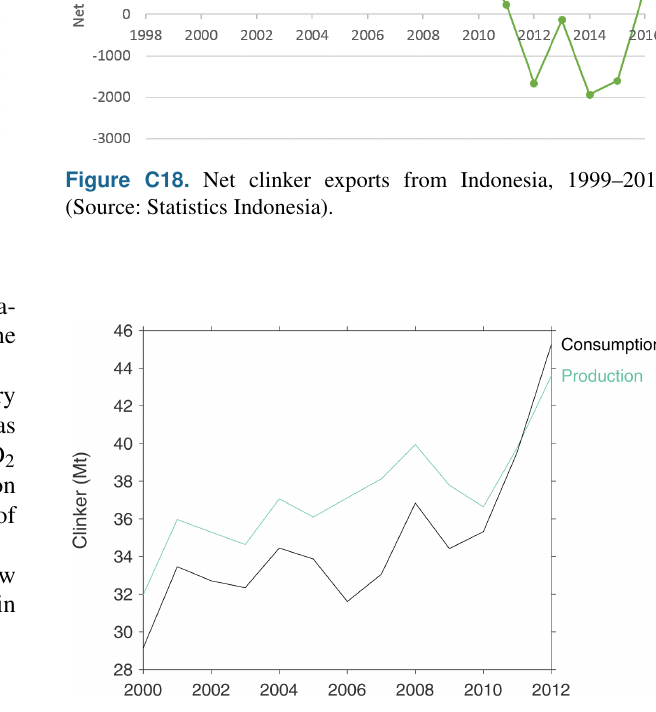
Figure C19. Indonesian clinker production and derived consump- tion, 2000–2012.